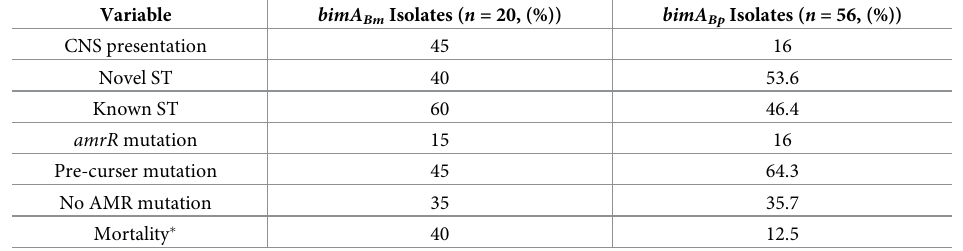
Table 2. Comparison of clinical presentation, sequence type and antimicrobial resistance within bimA bimA Bp -carrying B . pseudomallei